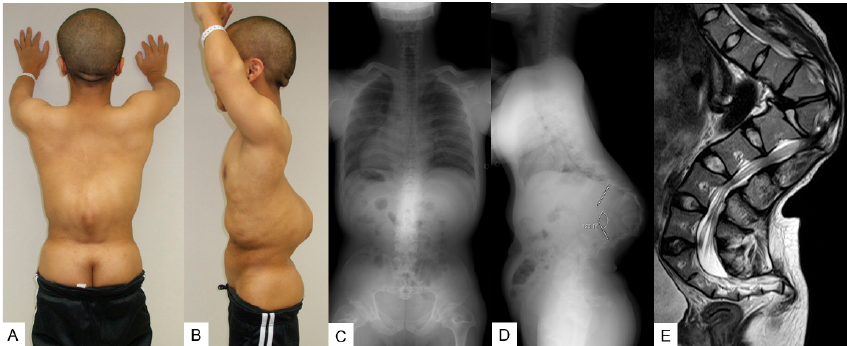
Figure 6. A 25-year-old man with achondroplasia; preoperative figure and radiograms. ( A , B ) The patient’s posture; ( C , D ) preoperative radiograms show T11-L2 local 123° kyphosis, SVA 62 mm, PT 25°, and PI 27°; ( E ) thoracolumbar sagittal T2-weighted MR imaging shows severe kyphosis and